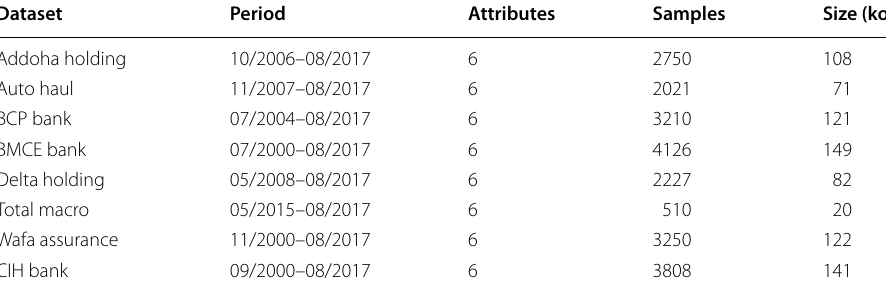
Table 4 Data sets